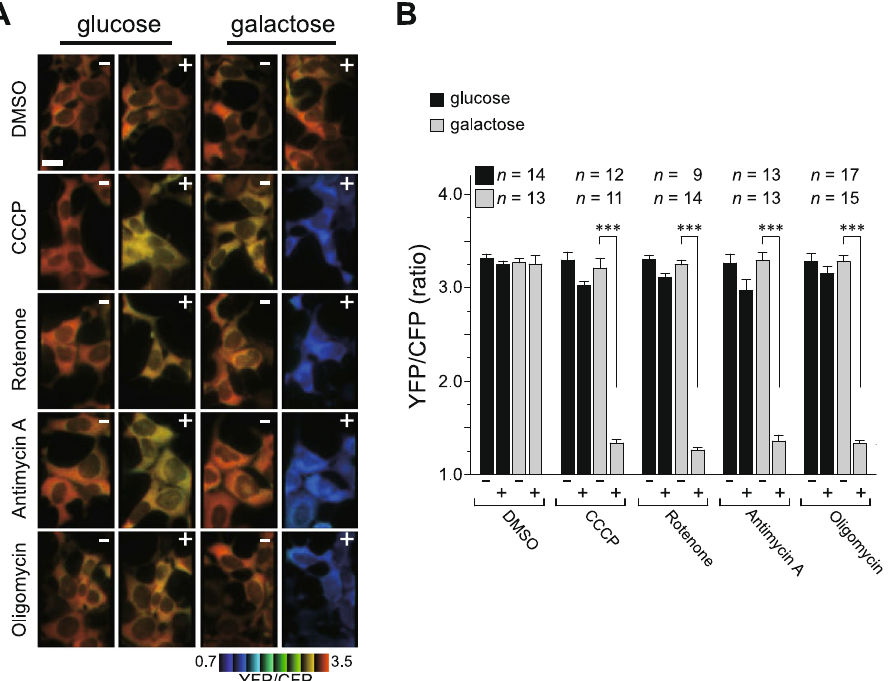
Figure 1. Bioenergetic profiling of cells under oxidative conditions. ( A ) HEK293 cells stably expressing the ATeam1.03 were cultured in customized media containing either galactose (right) or glucose (left) at 37 °C, and then the indicated mitochondrial inhibitors were added to each medium. The time-course of the fluorescence emission ratio (YFP/CFP) was monitored to visualize cytosolic ATP levels in each living cell, and ratiometric pseudocolor images of cells pre- ( − ) or post-treated ( + ) with inhibitors are shown. The images were processed in MetaMorph (Molecular Devices), and the blue color indicates less cytoplasmic ATP. Scale bar, 20 μ m. ( B ) Quantification of the YFP/CFP ratio calculated from images in ( A ). Number of cells ( n ) used for the quantification is shown at the top of the graph. Error bars indicate SD (Unpaired t -test; *** P <